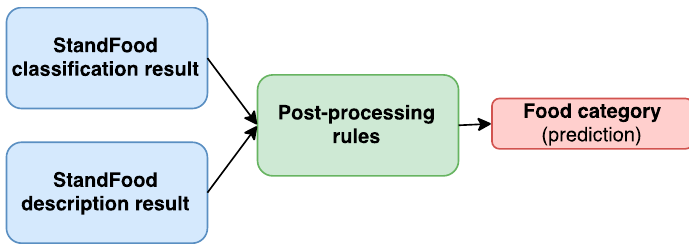
Figure 3. StandFood post-processing part. The results from the StandFood classification and description parts are combined together to improve the accuracy of the classification part for the food category prediction.